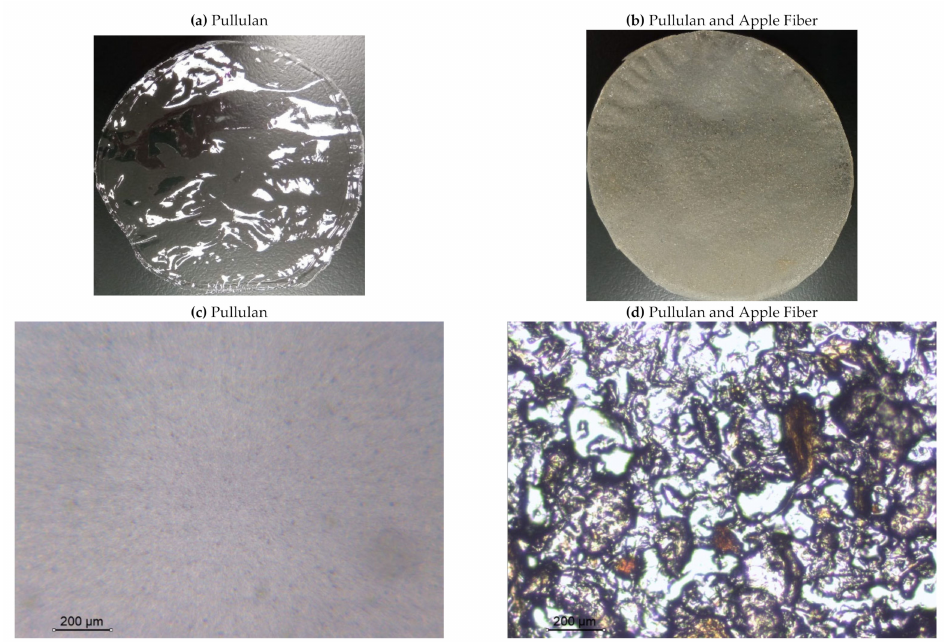
Figure 1. Appearance of the pullulan film ( a ), pullulan and apple fiber film ( b ), and surface morphology (optical microscopy, magnification: 400 × ) of the pullulan film ( c ), pullulan and apple fiber film ( d